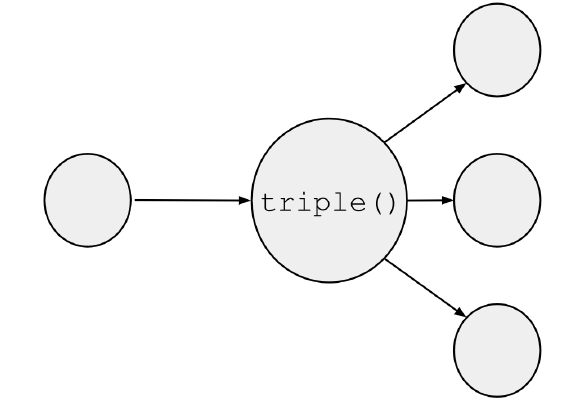
Figure 4. Graphic illustration of triple()